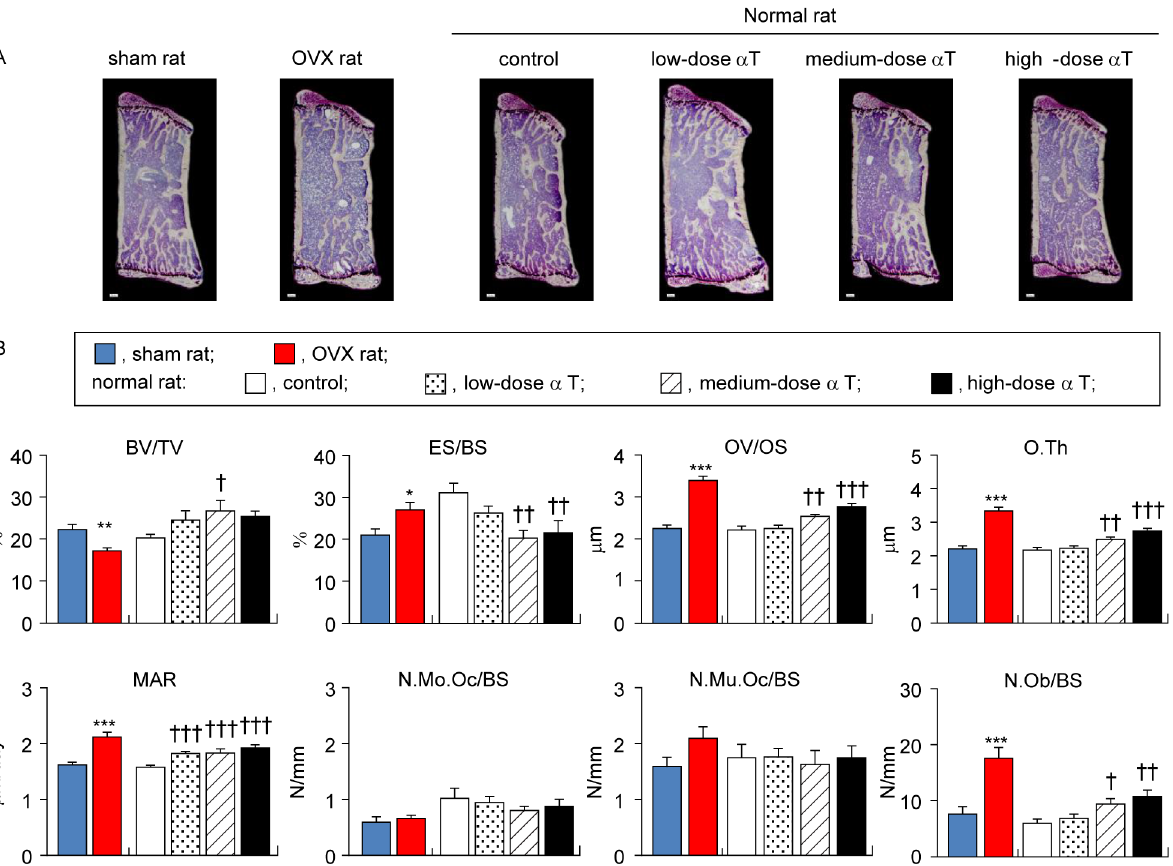
Fig 4. Histomorphometric analysis of secondary cancellous bones in vertebral body. (A) Representative micrographs of sagittal sections of vertebral bodies stained with Villanueva bone staining without decalcifying treatment are shown. (B) Histomorphometrical parameters (BV/TV, bone volume/tissue volume; ES/BS, eroded surface/bone surface; OV/OS, osteoid volume/osteoid surface; O.Th, osteoid thickness; MAR, mineral apposition rate; N.Mo.Oc/BS, number of mononuclear osteoclast/bone surface; N.Mu.Oc/BS, number of multinuclear osteoclast/bone surface; and N.Ob/BS, number of osteoblast/bone surface) of secondary spongiosa in vertebral bodies are shown. Data are presented as mean ± standard error of the mean. * P < 0.05, ** P < 0.01, and *** P < 0.001 vs. sham rat group; † P < 0.05, †† P < 0.01, and ††† P < 0.001 vs. normal rat control group.